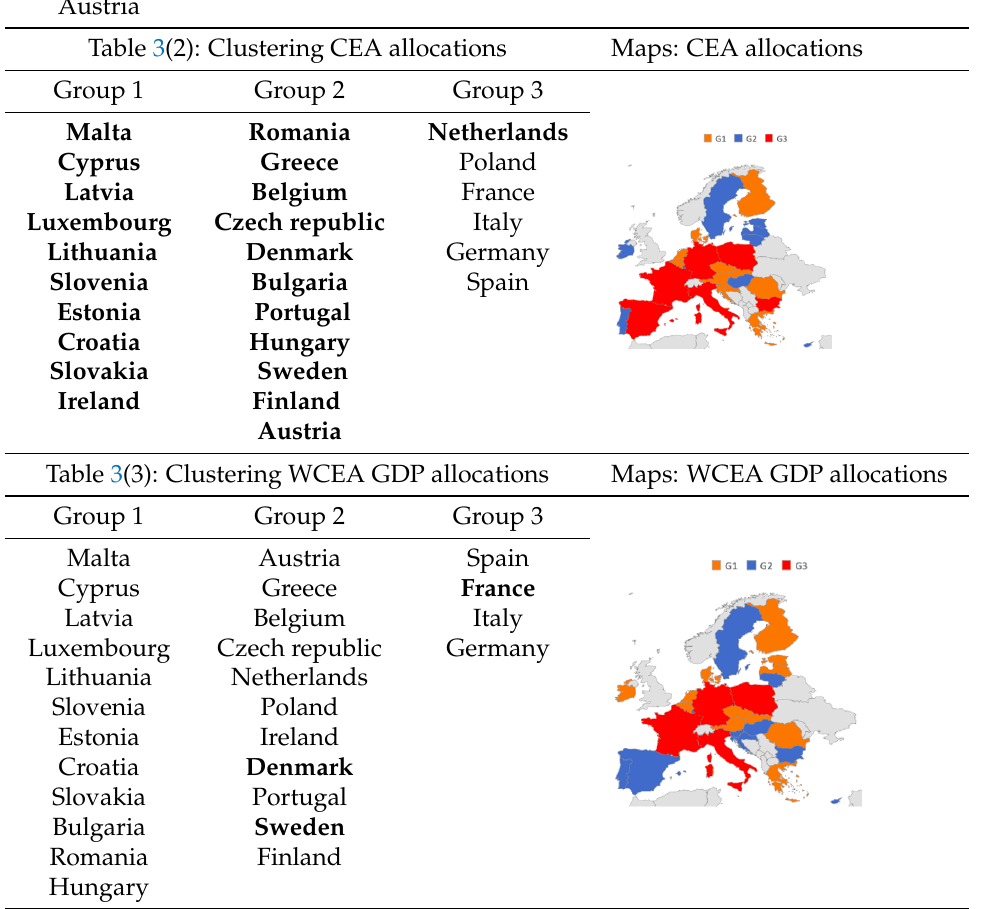
Table 3(2): Clustering CEA allocations Maps: CEA allocations